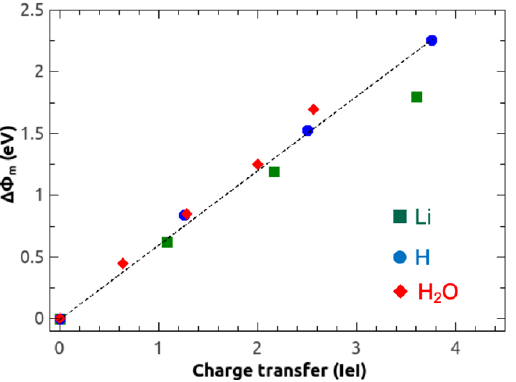
Figure 12. Computed work function shift ∆Φ m as a function of the charge transferred to the 1T-MoS 2 layer (calculated as the product of the adsorbate coverage and partial charge transferred to 1T-MoS 2 from Table 2) [62]. The dashed line guides the eye.